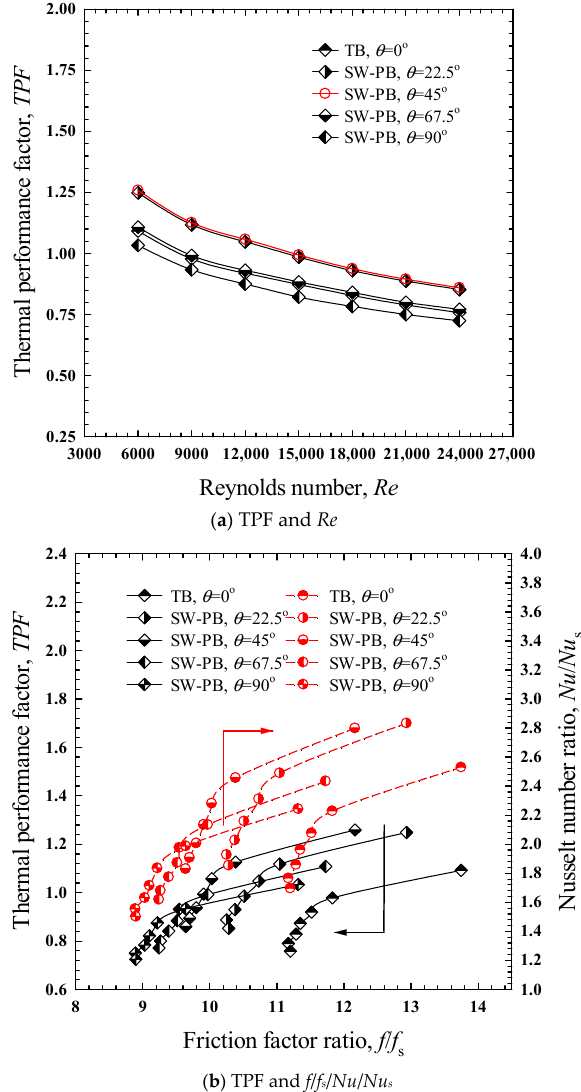
Figure 8. Thermal performance of a channel with square-winged transverse baffles (SW-TBs).